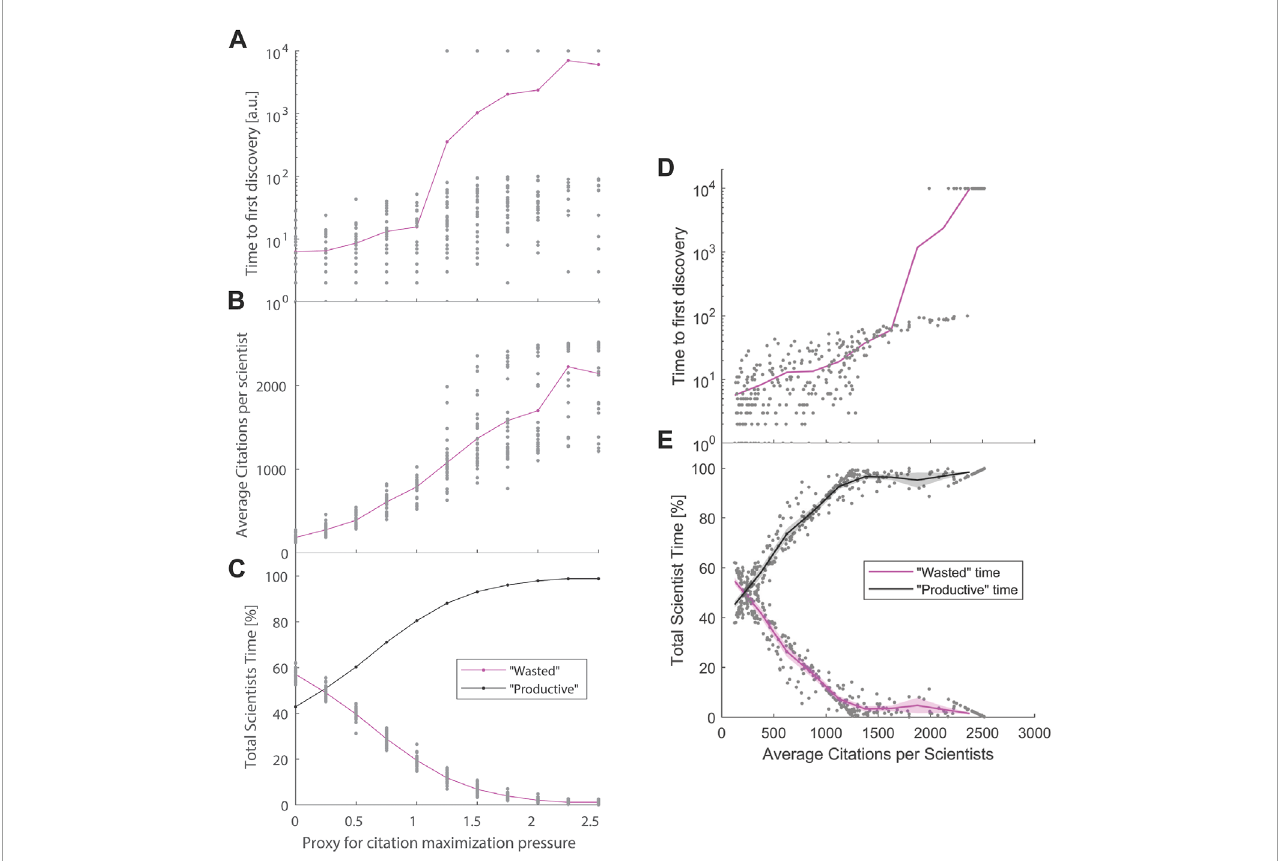
FIGURE 2 Statistics from an ensemble of model runs for different citation pressures. (A) The time to the first discovery increases with increasing citation pressure. (B) Average citation per scientist tracks the citation pressure parameter in the toy model. (C) Fraction of total “productive” time or share of total time spent gathering citations increases with increasing citation pressure. (D) Time to first discovery is longer with increasing average citations per scientist. (E) Fraction of total “productive” time increases with average citations per